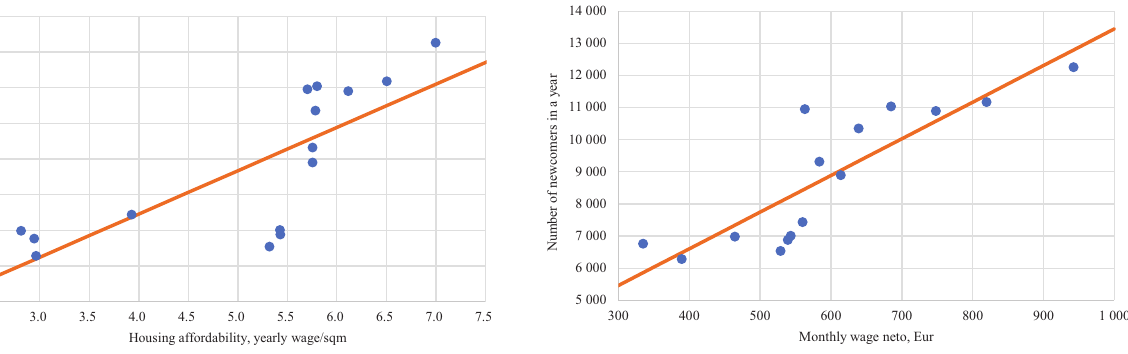
Figure 1. Impact of housing affordability on the number of newcomers to Vilnius in 2005−2019